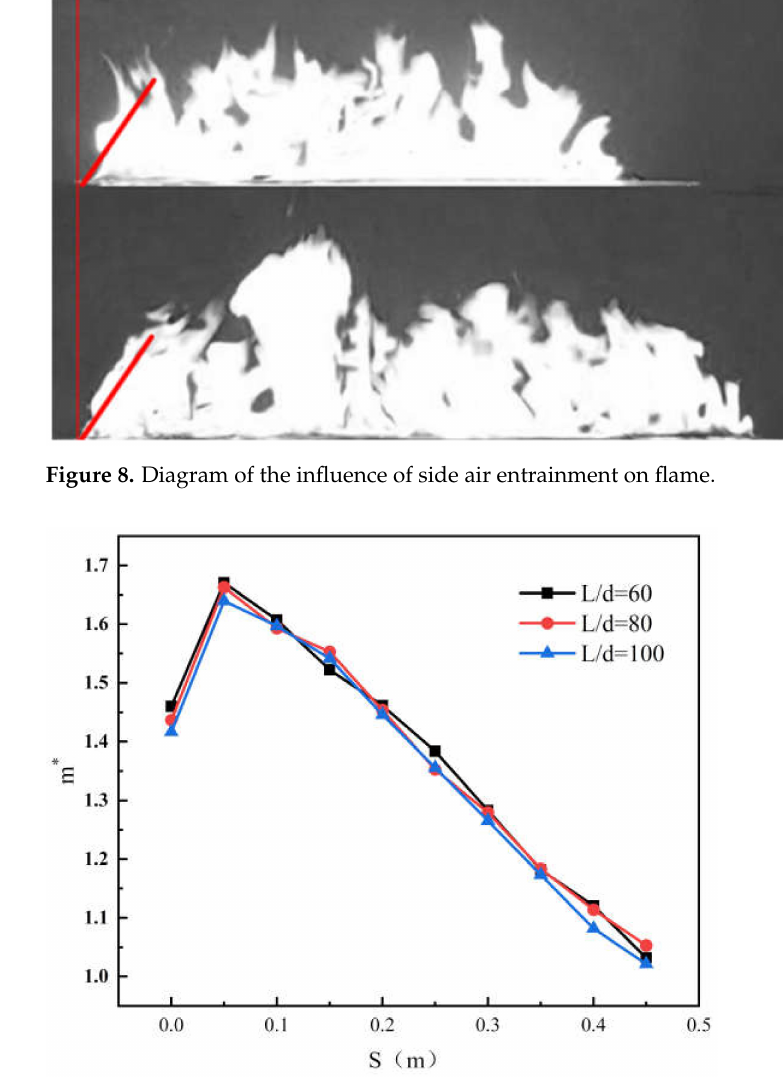
Figure 9. Variation law of dimensionless burning rate with fire-source